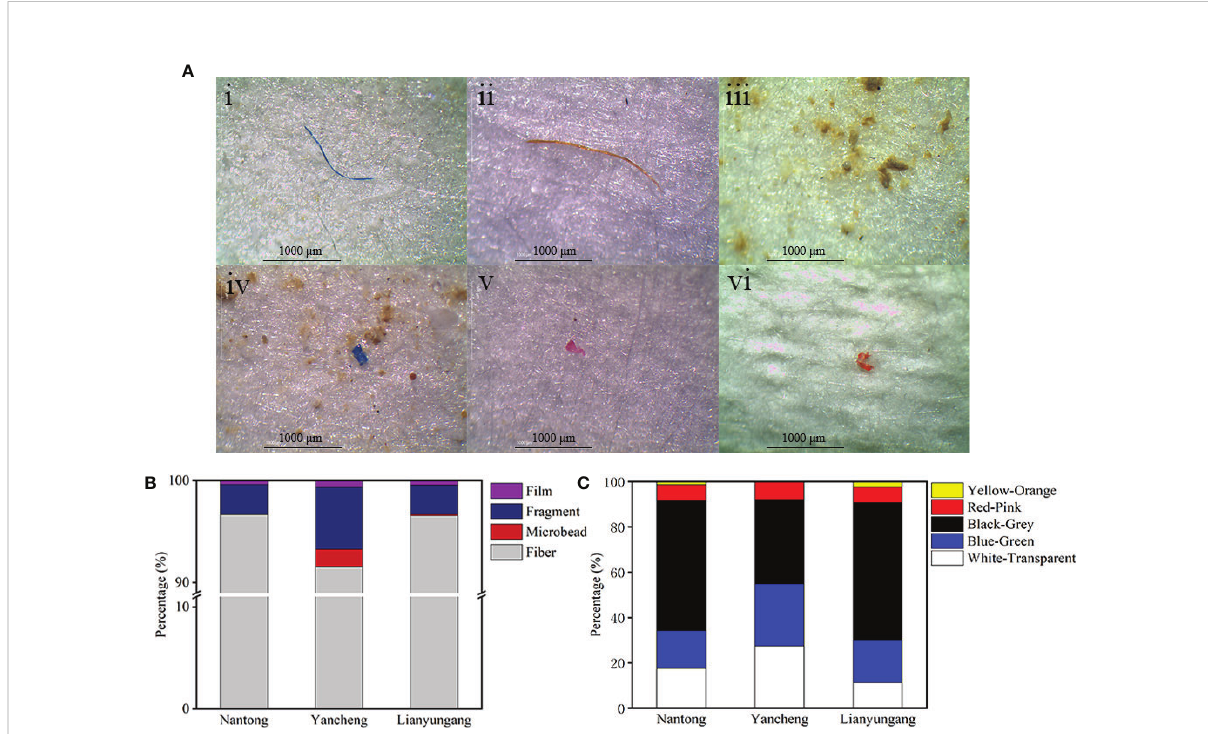
FIGURE 4 Micrographs of several typical MPs (A) and the shape (B) and color (C) distribution of MPs observed in clam samples. (i) blue fi ber, (ii) orange fi ber, (iii) white microbead, (iv) blue fragment, (v) red fragment, (vi) red fi